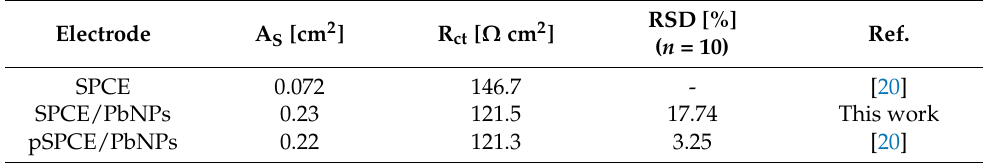
Table 1. Characteristics of the sensors.